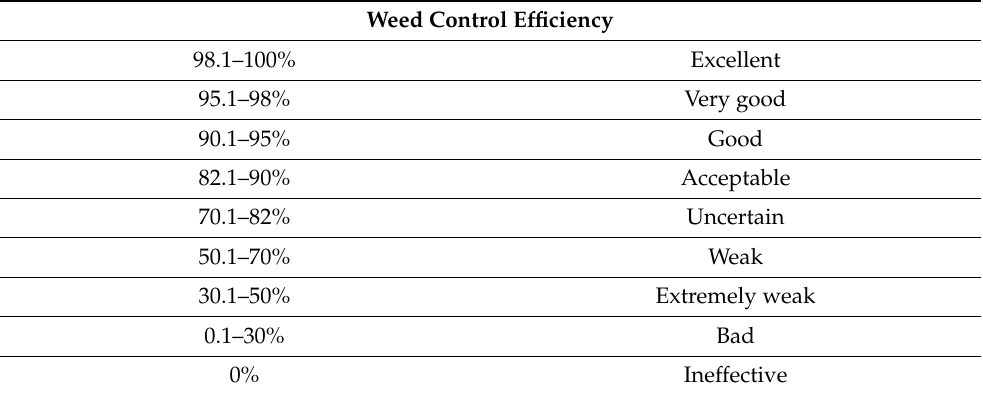
Table 3. Evaluation of weed control efficiency in nine